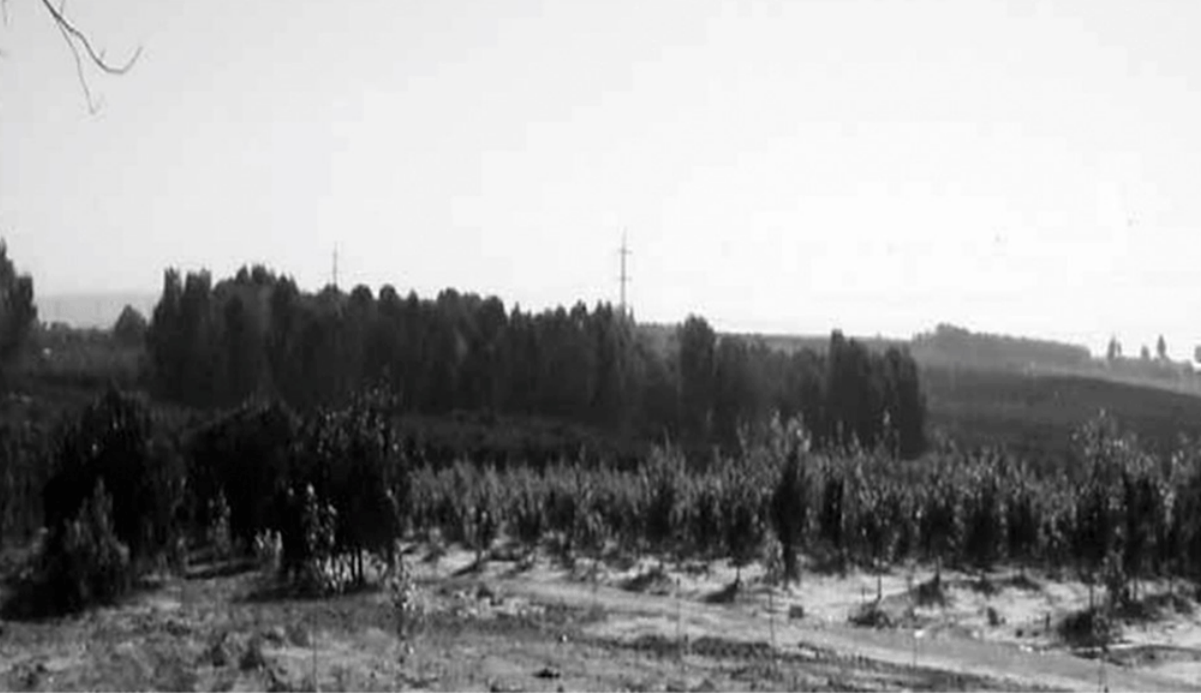
Figure 3. Landscape of Erasure : Miska today. After the village was bulldozed down in 1952, the Eucalyptus grove—the thick wooded area—was planted by the Israeli Land Association (ILA) to cover the scars and ruins. (Summer 2006, Printed with permission of